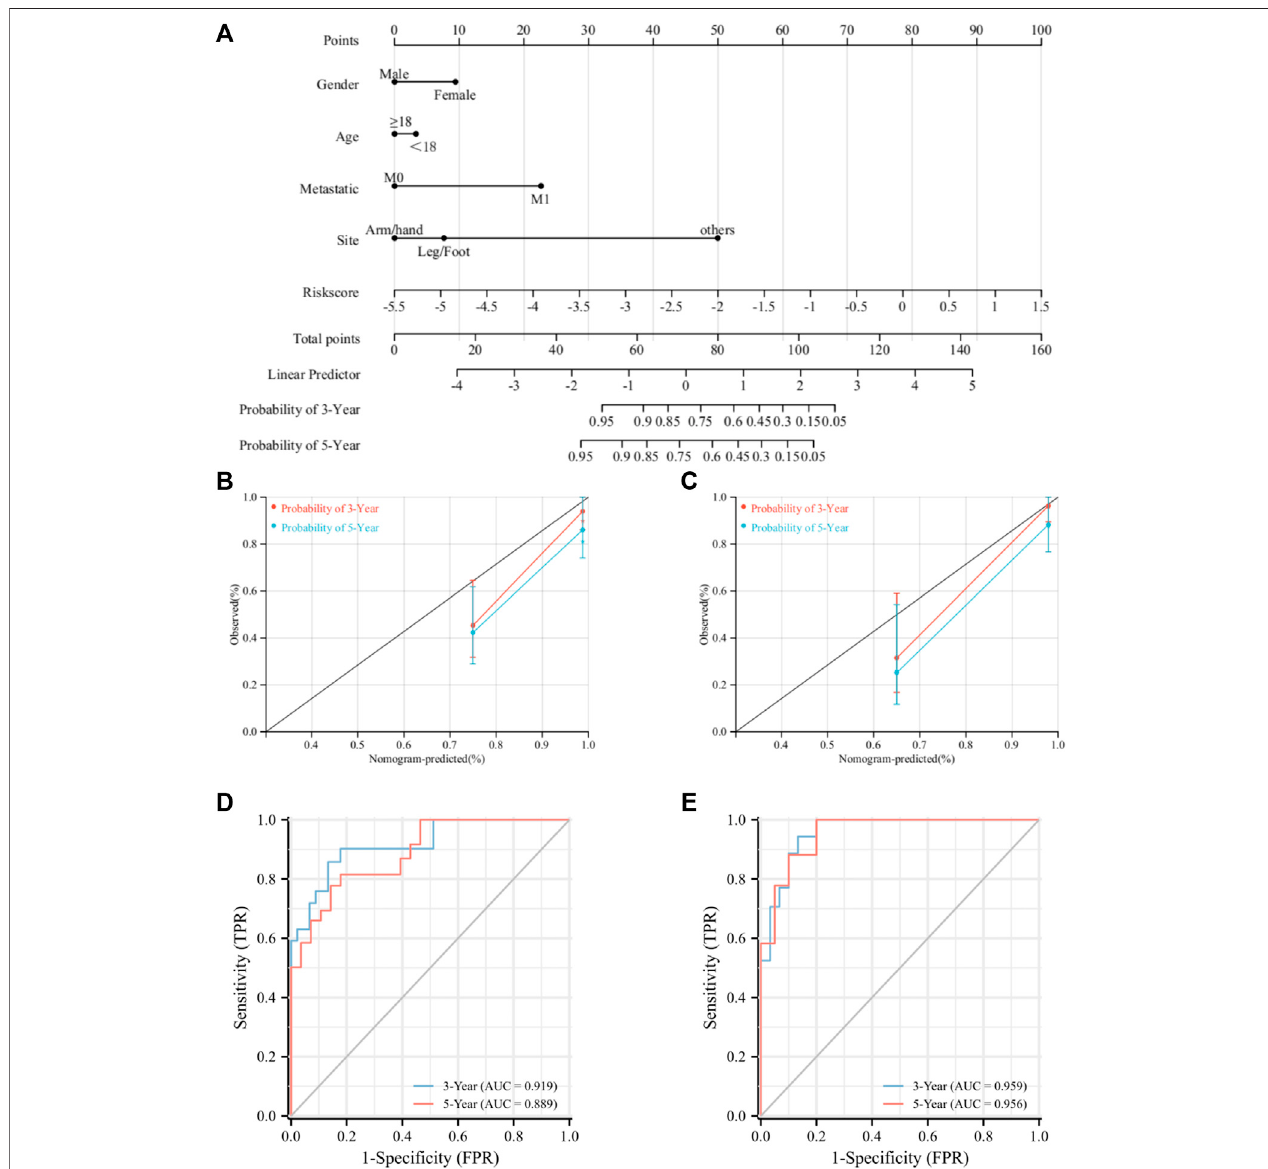
FIGURE7| Constructionandevaluationofthenomogram. (A) .Nomogramforpredictingtheprognosisofpatientswithosteosarcoma. (B) Calibrationfor3-and5- yearOSinthetrainingcohort. (C) Calibration for3-and5-yearOSintheveri fi cation cohort. (D) ROCanalysisfor3-and5-yearOSinthetrainingcohort. (E) ROCanalysis for 3-and 5-year OS in the veri fi cation